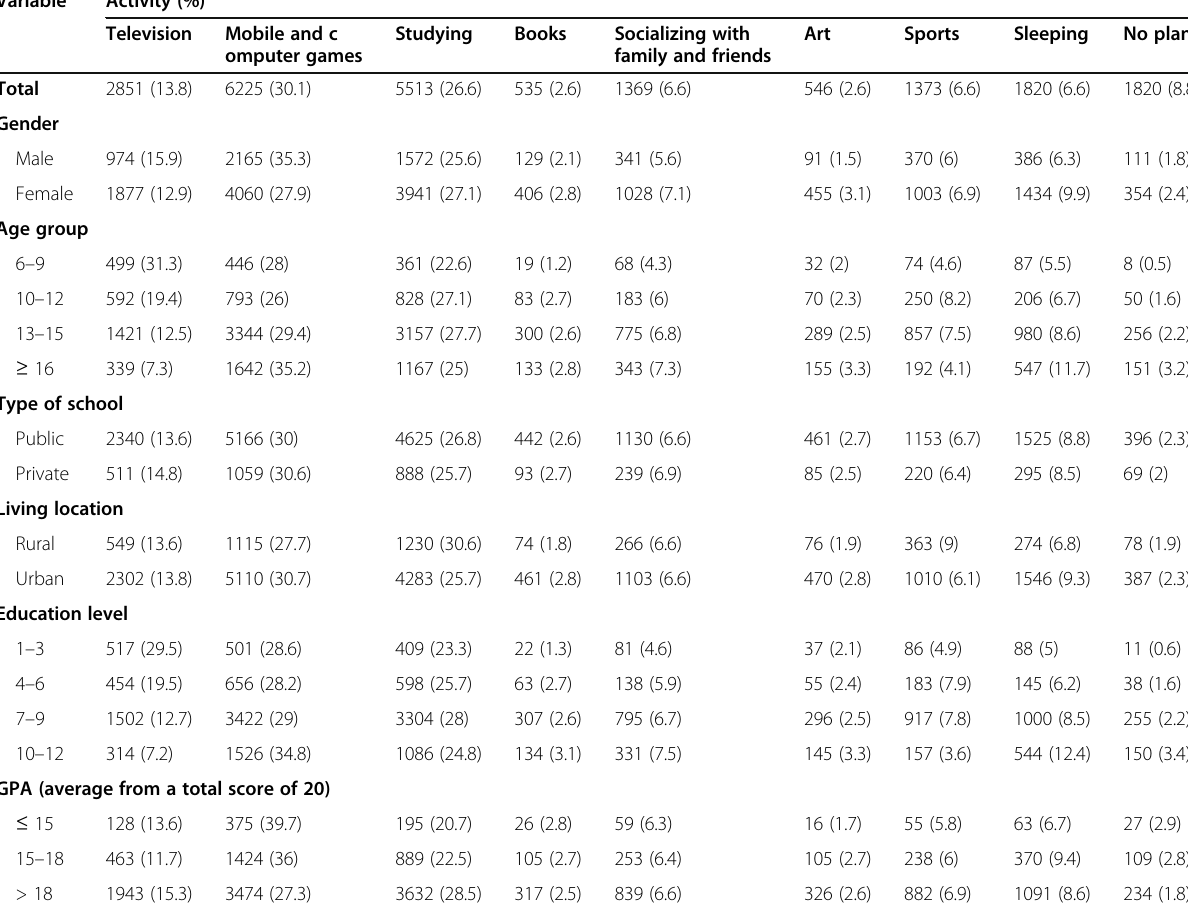
Table 4 The first preference of students during school closure due to the COVID-19 pandemic